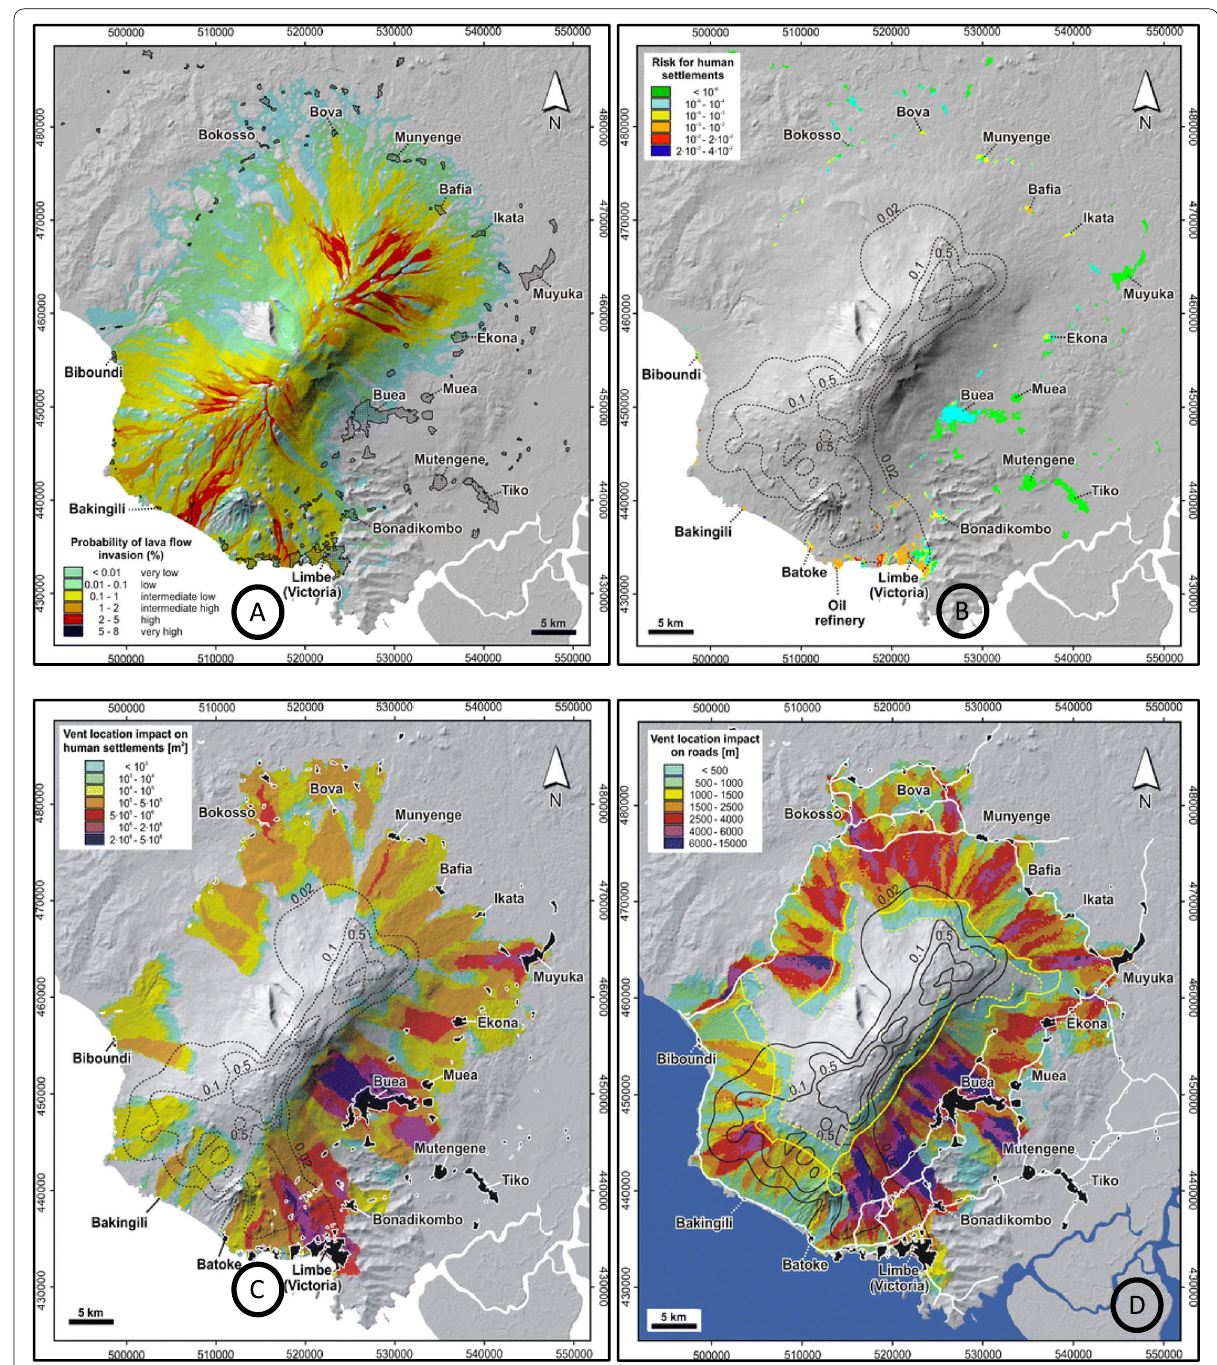
Fig. 4 Risk maps of probability of lava flow inundation ( A ), human settlements ( B ), vent location impact on human settlements ( C ), and vent location impact on roads ( D ) on Mt. Cameroon. Source: Favalli et al.